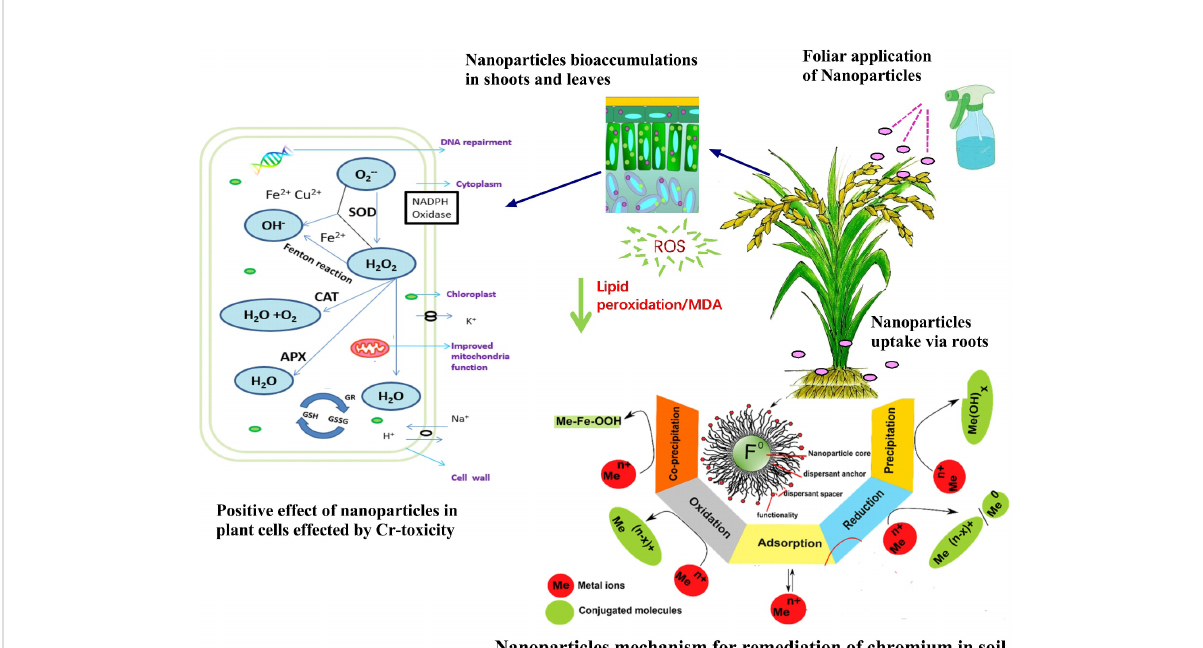
FIGURE 4 Nanoparticles (NPs) application reduced oxidative stress in plant species. Under chromium (Cr) toxicity, cellular respiration produces O 2 .- that is converted into hydrogen peroxide by the activity of superoxide (SOD). H 2 O 2 is then converted into O 2 and H 2 O by the combined activities of ascorbate peroxidase (APX), catalase (CAT), glutathione reductase (GR), and glutathione peroxidase (GPX). NPs minimizes the accumulation of O 2 .- and H 2 O 2 . The reactive oxygen species (ROS) which causes lipid peroxidation, enzyme inactivation, and cell death. The activity of ROS was signi fi cantly minimized by NPs due to improved production of antioxidants i.e., CAT, SOD, and POD (Ali et al., 2021). Mechanism